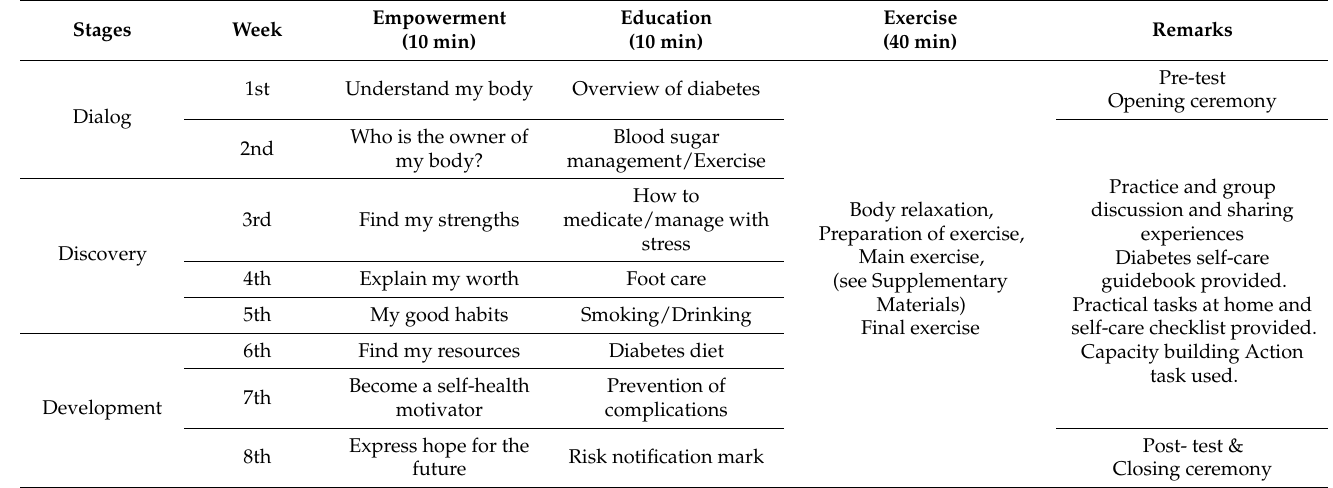
Table 1. Contents of the Dia-Empower